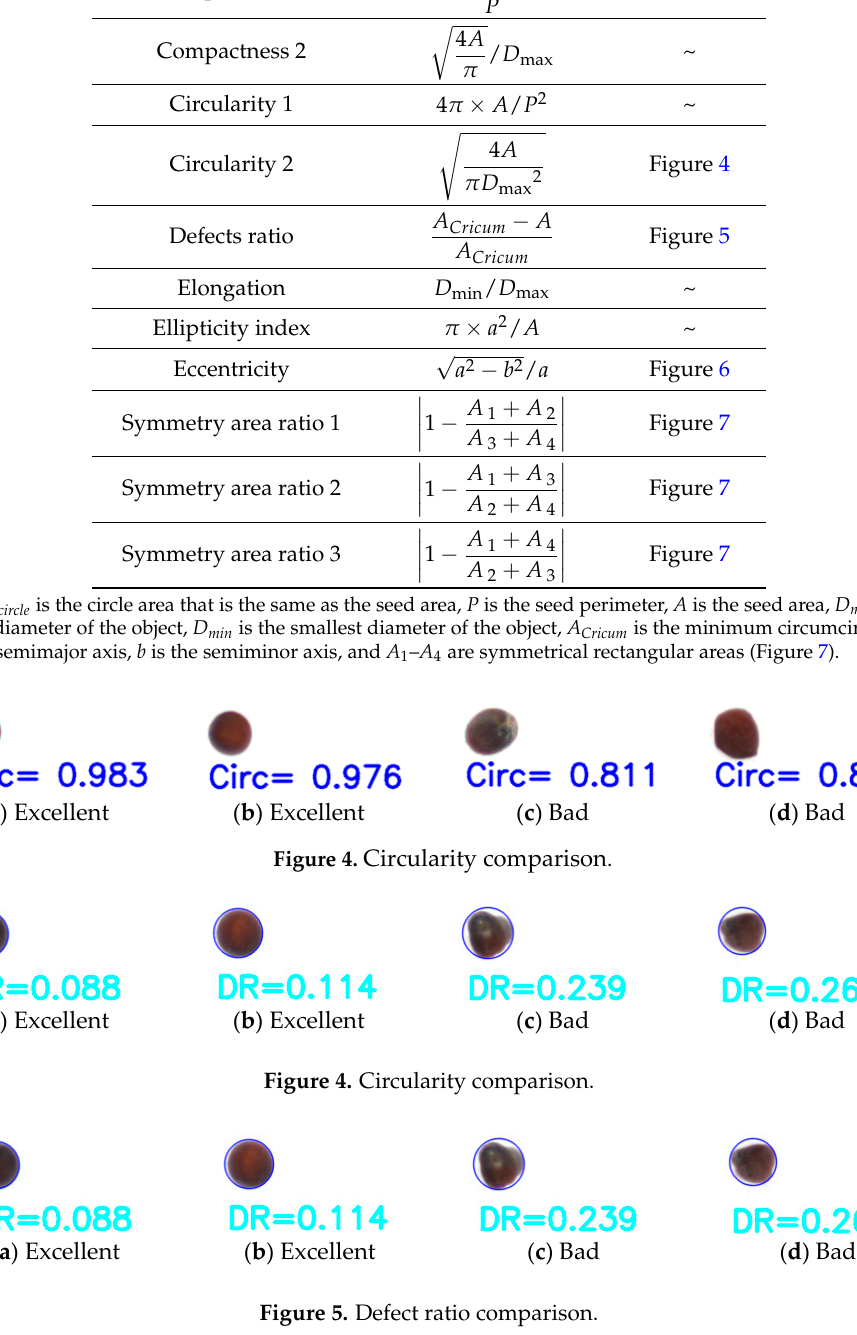
Figure 5. Defect ratio comparison .